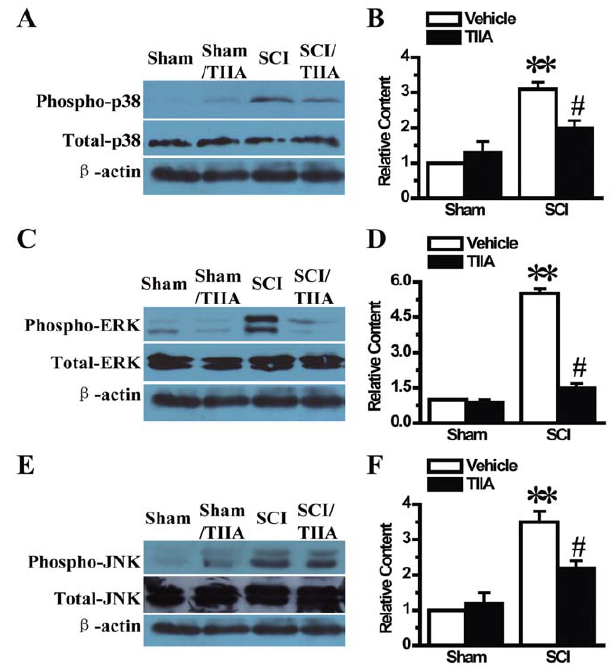
Figure 5. Effects of TIIA on MAPK pathway at 24 h after SCI. The expression of p-p38 was up-regulated in the SCI group compared with the sham and sham/TIIA groups. The level of p-p38 was attenuated with TIIA treatment as compared to the SCI group (A). The analyzed data for p-p38 are shown (B). The content of p-ERK was significantly increased in the SCI group at 24 h compared with the sham and sham/TIIA groups. TIIA prevented the expression of p-ERK (C). The analyzed data for p-ERK are shown (D). p-JNK was up-regulated after SCI, but a significant reduction of p-JNK in the tissues from the SCI/TIIA group was observed (E). The analyzed data for p-JNK are shown (F). Bars represent means 6 SEM. ** p , 0.001 vs. sham group, # p , 0.05 vs. SCI group.